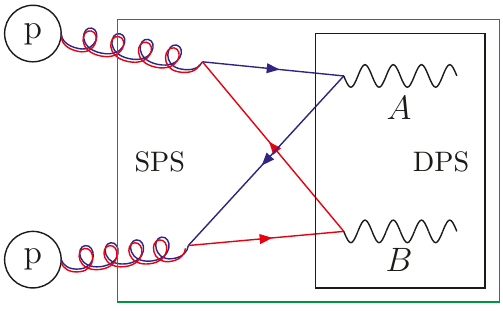
Figure 3 . Example of a process which can be seen either as a DPS or as a SPS. If the hard process is de(cid:12)ned by the black box, then it is a DPS with the two subprocesses q(cid:22)q the case where the hard process is de(cid:12)ned by the green box, then one has the SPS gg The pieces which are not included within the boxes are integrated out inside the